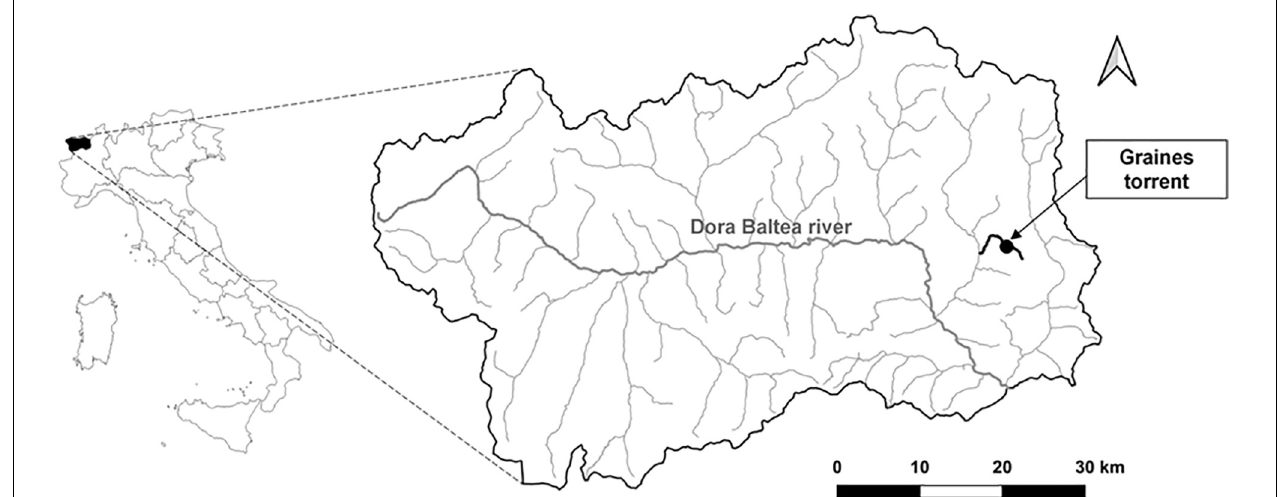
FIGURE 1 | Location of the Graines torrent and HP plant (black dot symbol) in the Aosta Valley region (NW Italy).